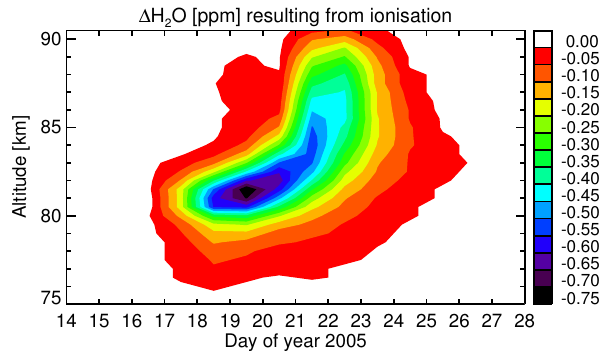
Fig. 15. Difference of the water mixing ratio [ppm] at 75 ◦ S be- tween a model run with ion chemistry and a model run without ion chemistry. The negative values correspond to the ion chemical water depletion.